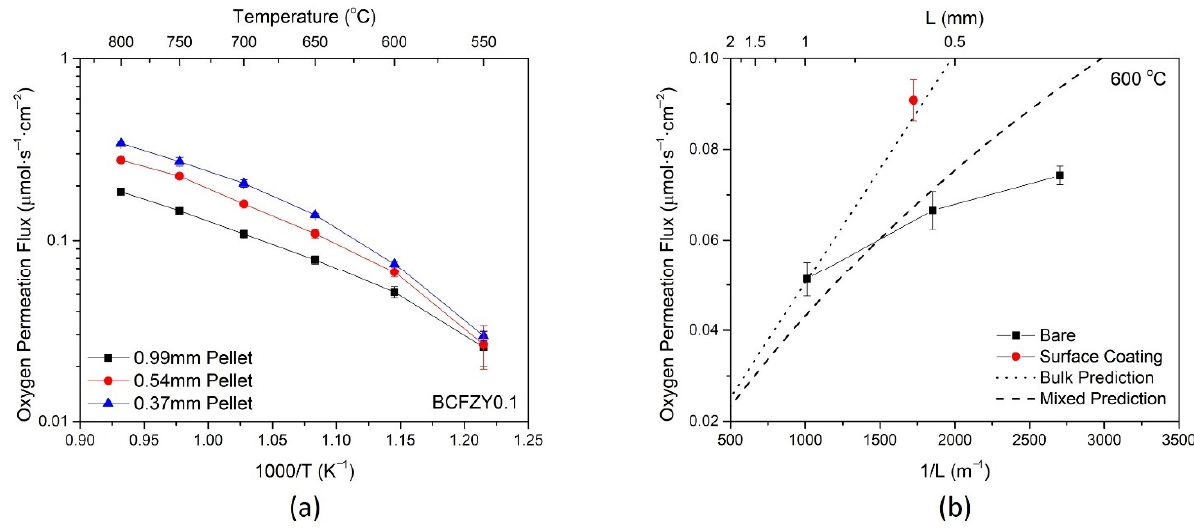
Figure 4. Oxygen permeation flux for the BCFZY0.1 sample ( a ) as a function of temperature, under varying thicknesses, and ( b ) as a function of thickness at 600 °C.